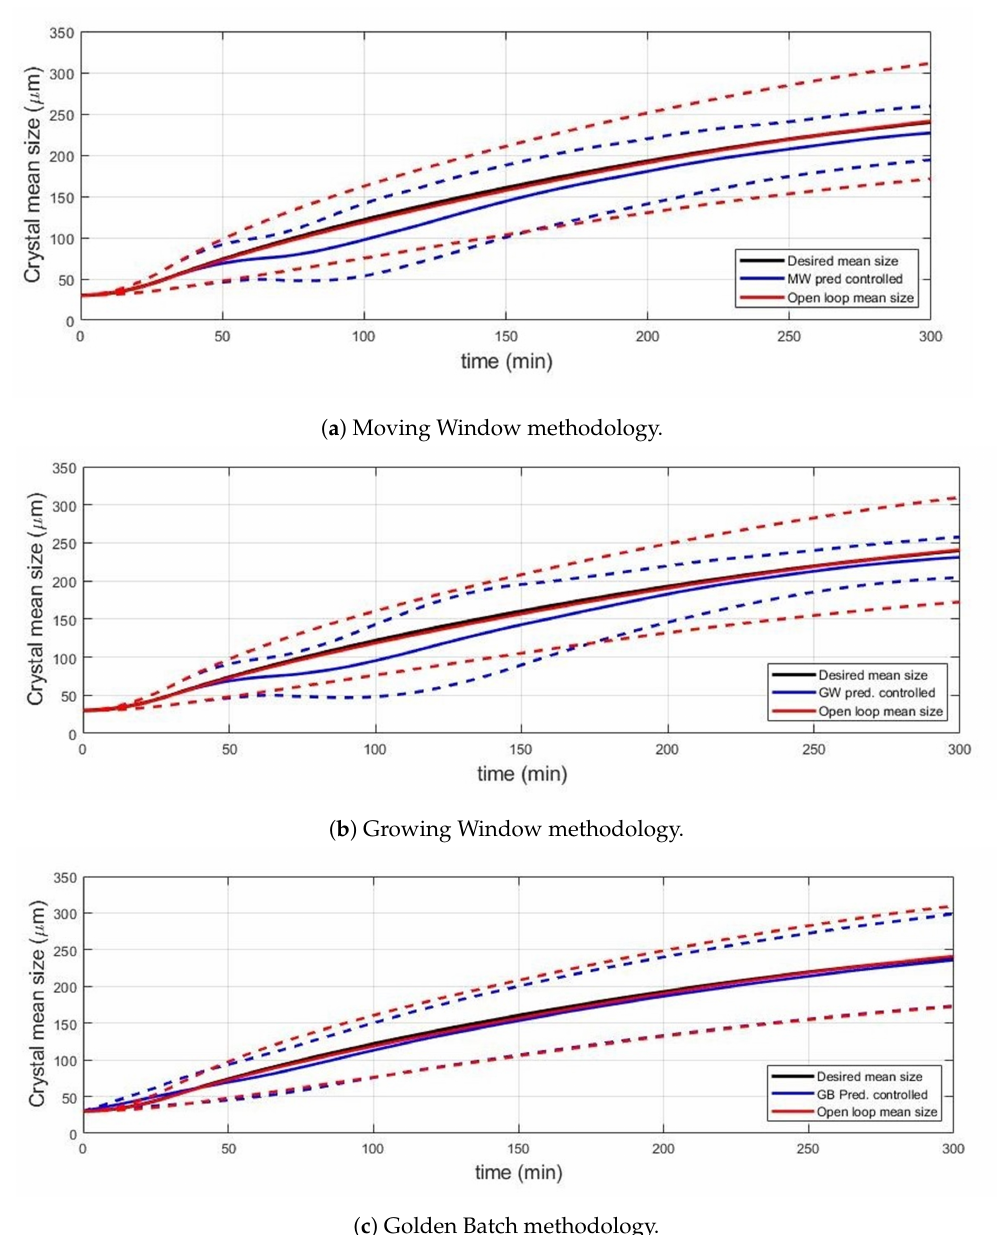
Figure 8. 95% confidence interval of controlled and open-loop cases obtained for the application of the different methodologies to the RBF predictive control with Monte Carlo sampling disturbances (300 LHS samples